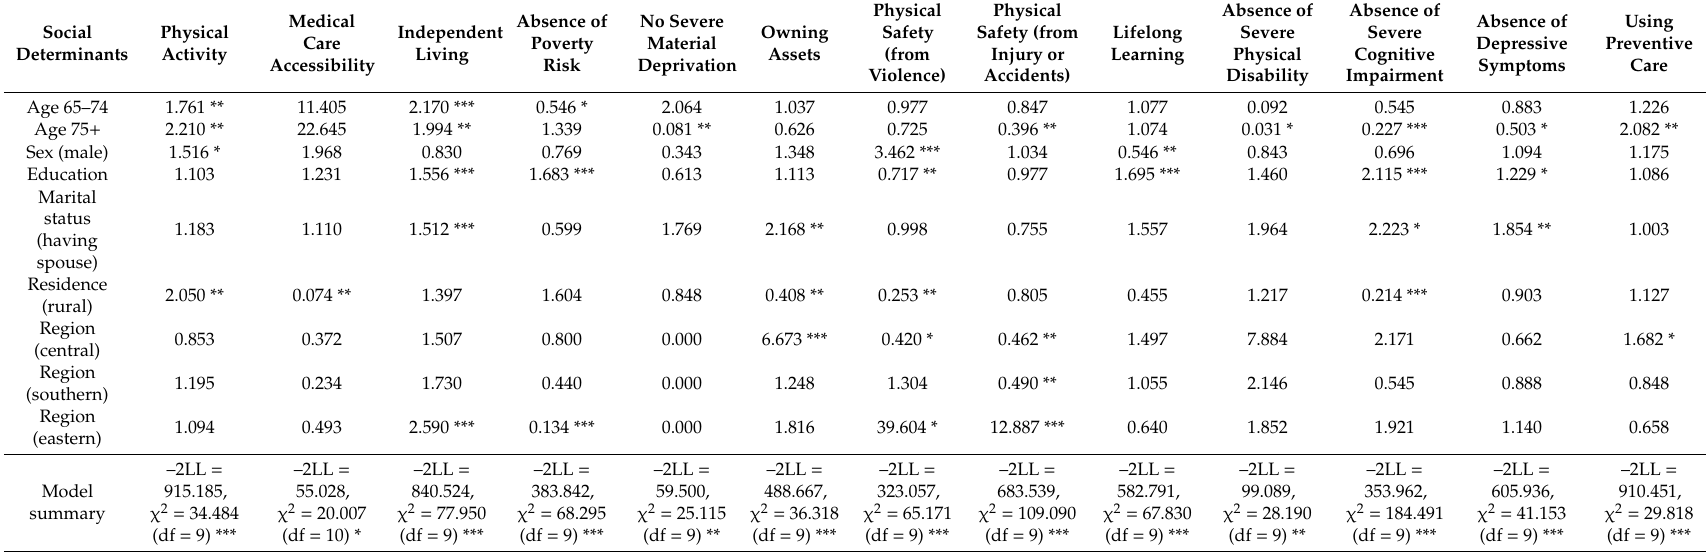
Table 4. Independent, healthy, and secure living indicators and social determinants by logistic